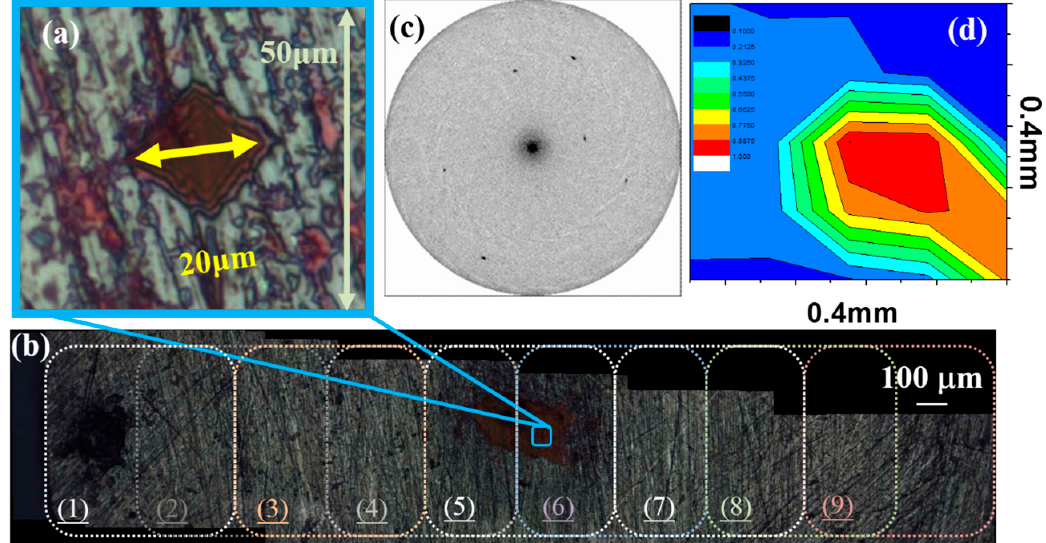
Figure 1. Synchrotron measurements: ( a ) the indented region of the specimen is set at the center; ( b ) nine measured areas in one direction are scanned and overlapping each other; ( c ) ypical diffraction spots of the measured results, which are from the Ni 50 Al 50 sample; ( d ) normalized diffraction peak-width distribution of Ni 50 Al 50 . Figure 2. Lattice-strain distributions of (110) as squares ( ■ ), (200) as circles ( ● ), and (211) as triangles ( ▲ ), respectively, around indented centers for ( a ) Ni 50 Al 50 ; ( b ) Ni 49.875 Al 49.875 Fe 0.25 ; and ( c ) Ni 49.5 Al 49.5 Fe 1 .